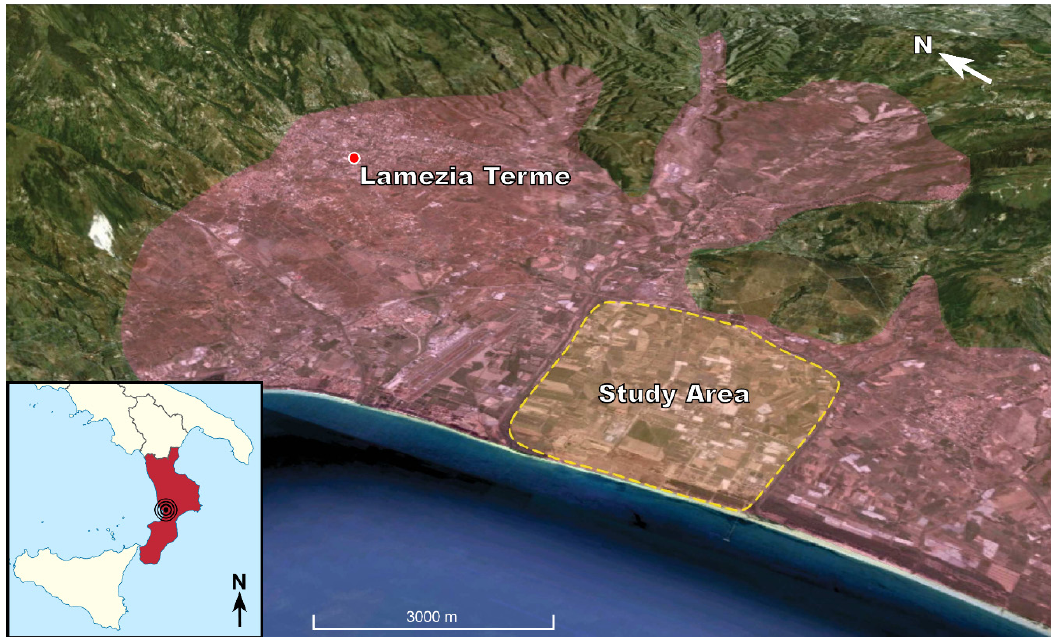
Figure 2. Aerial view of the Lamezia Terme District (pink background) and study area location (yellow background), Italy. Image taken from Google Earth.